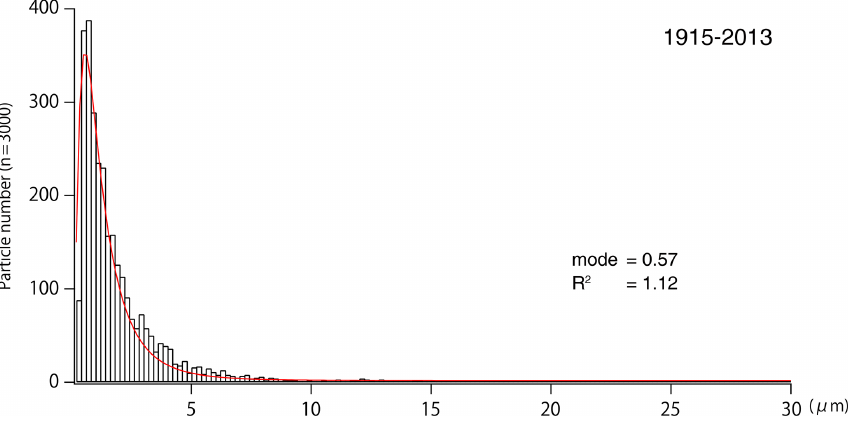
Clim. Past, 17, 1341–1362,